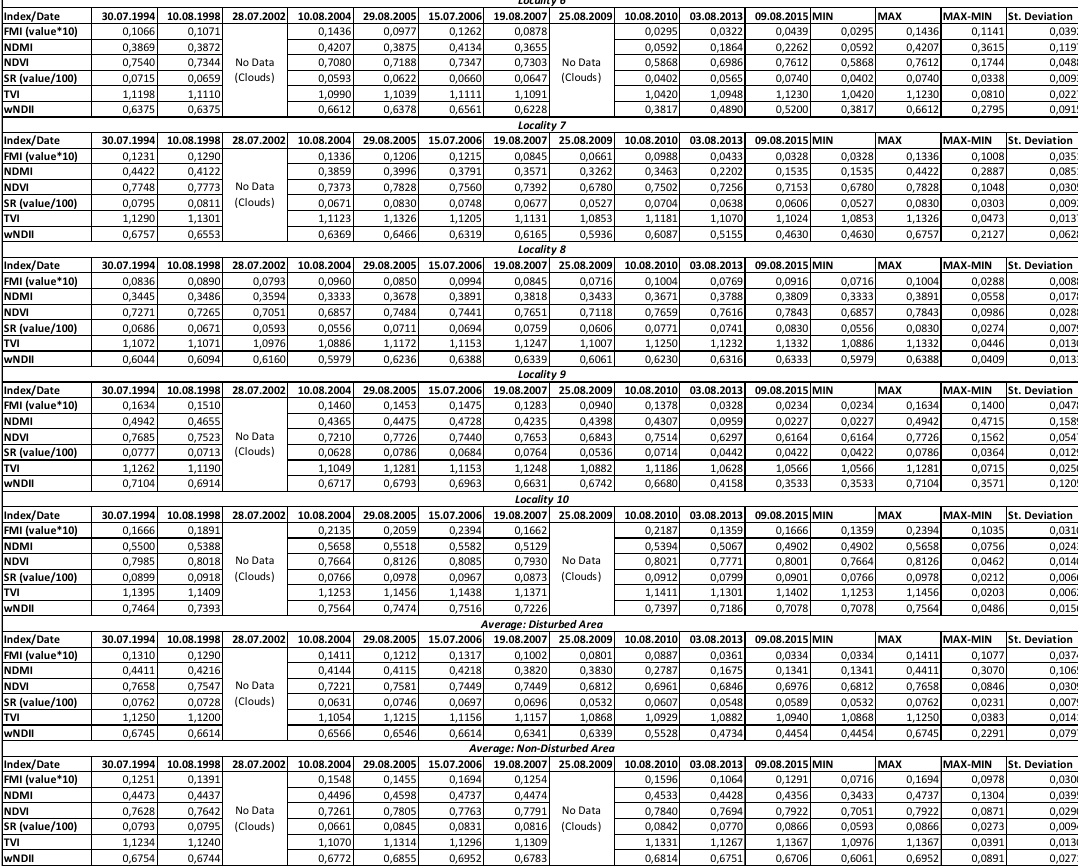
Figure A2. Statistical information about the vegetation indices values in the Sumava NP (Source: Own work).